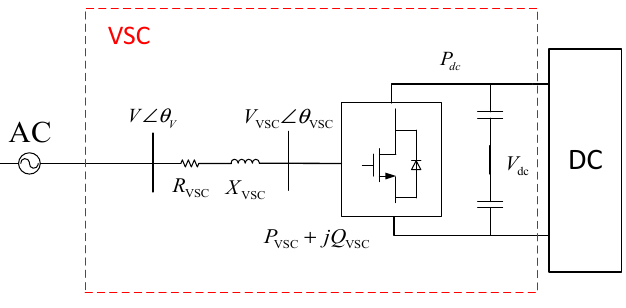
Figure 1. Voltage source converter (VSC) model.